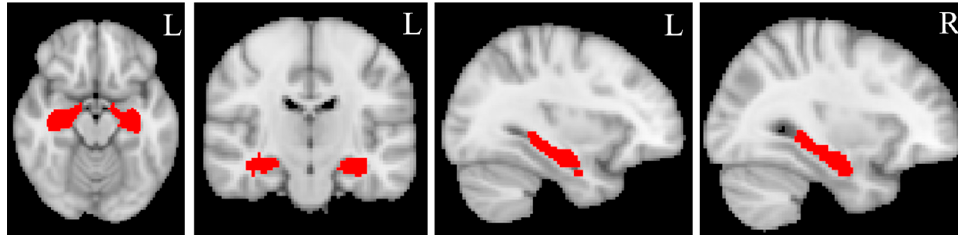
Figure 2. Hippocampal masks. The bilateral hippocampal masks are created from Automated anatomical labeling (AAL) atlas, version 1, in standard MNI space using “fslmaths”, a function implemented in FSL. L = left, R = right. The red color represents the bilateral hippocampal masks.